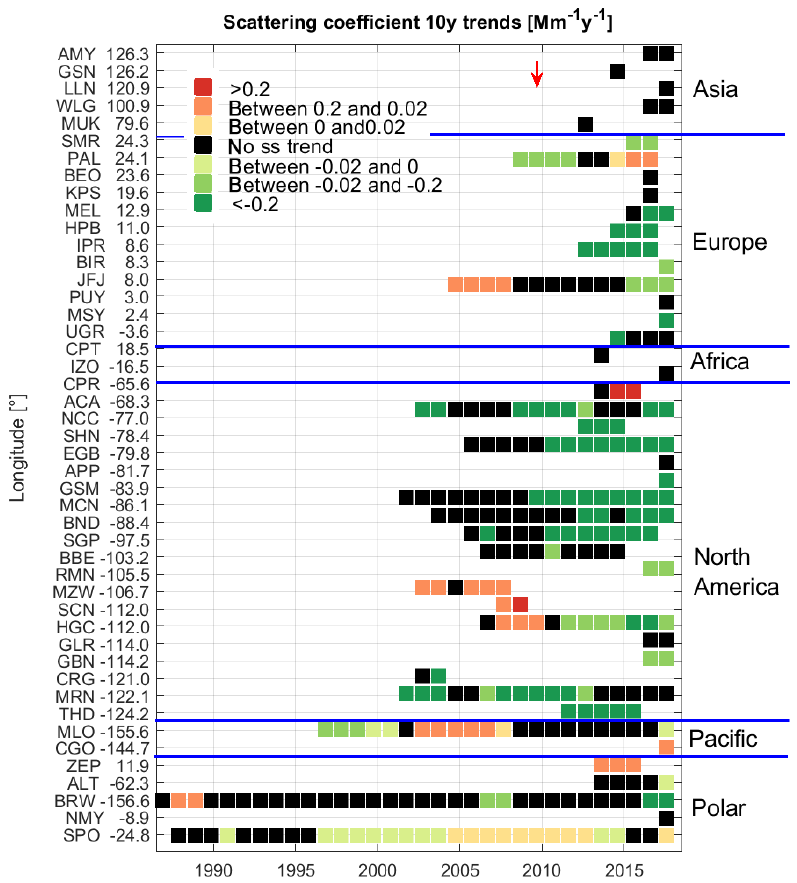
Figure 12. Time series of sequential 10-year σ sp trends as a function of station longitude. Stations in the South Pacific and in the polar regions were grouped for clarity. The red arrow indicates the end of the time periods covered in